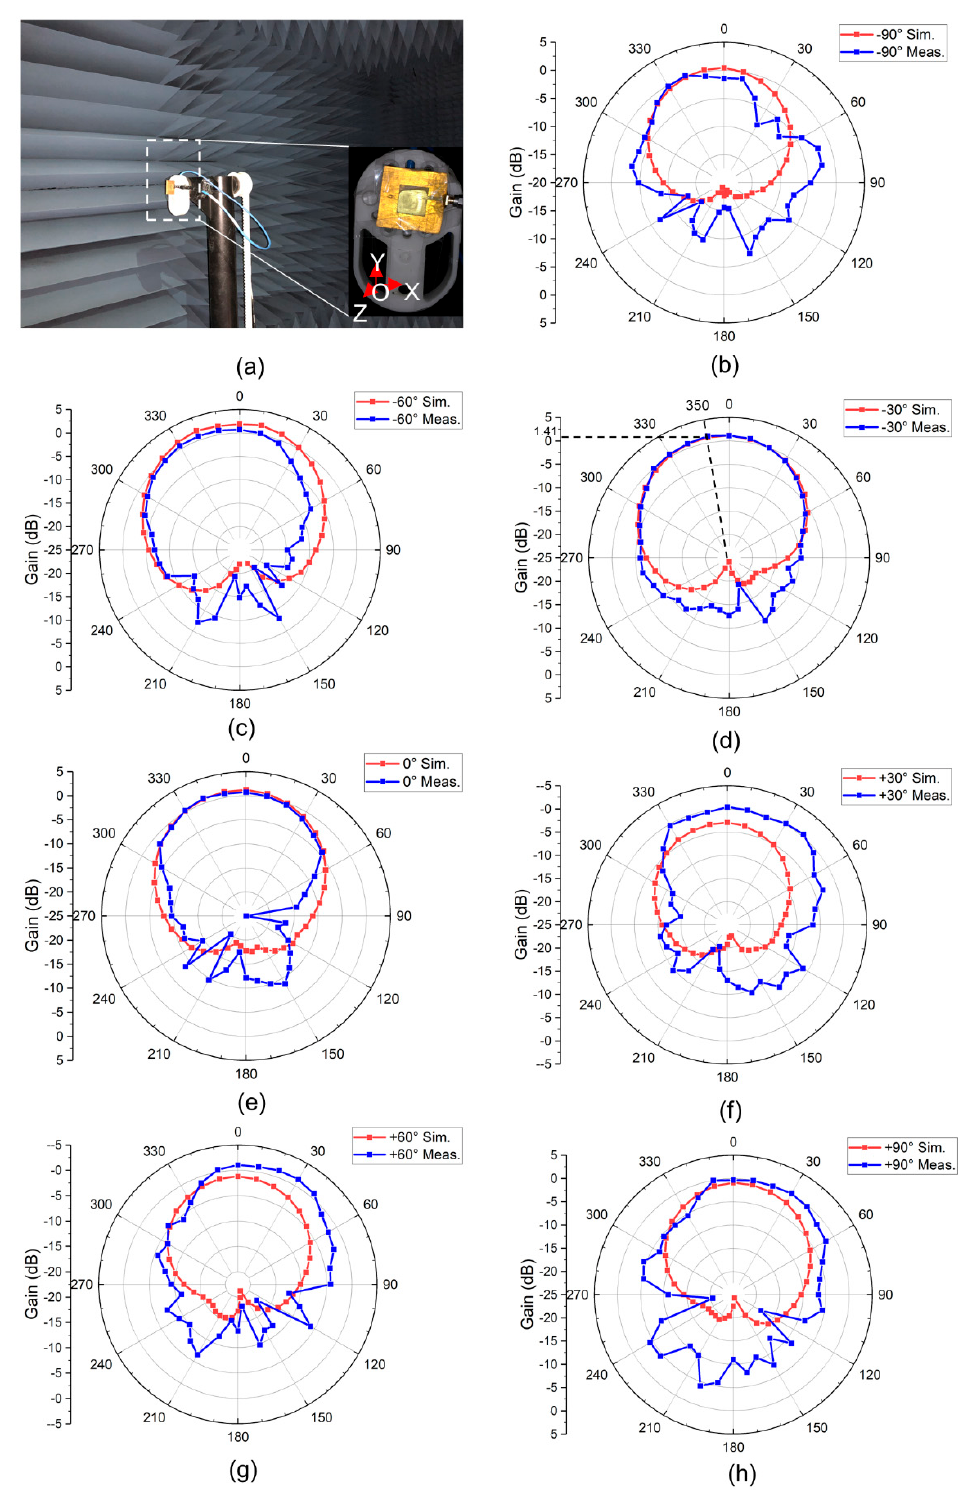
Figure 8. ( a ) The test environment in the microwave anechoic chamber. ( b – h ) Simulation and measurement results for the antenna’s E-plane (X-O-Z plane) radiation patterns for various frequencies, where the rotation angle is increased from − 90° to +90° in steps of 30°.